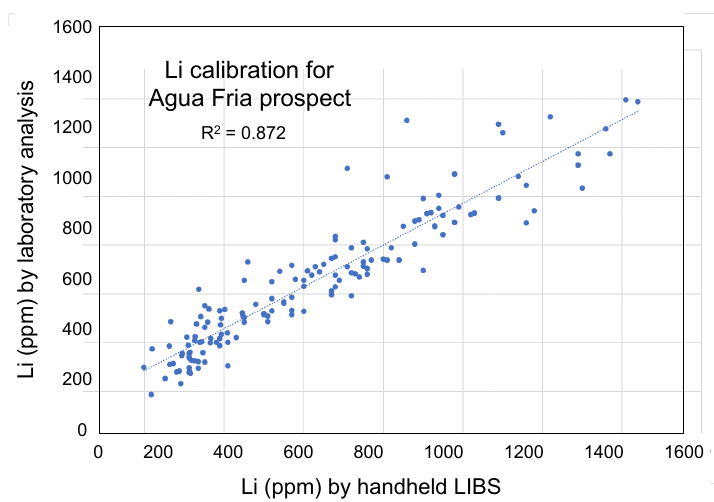
Figure 13. Comparison of Li concentrations for the Agua Fria Li prospect drilling samples by handheld LIBS and certified laboratory assay.